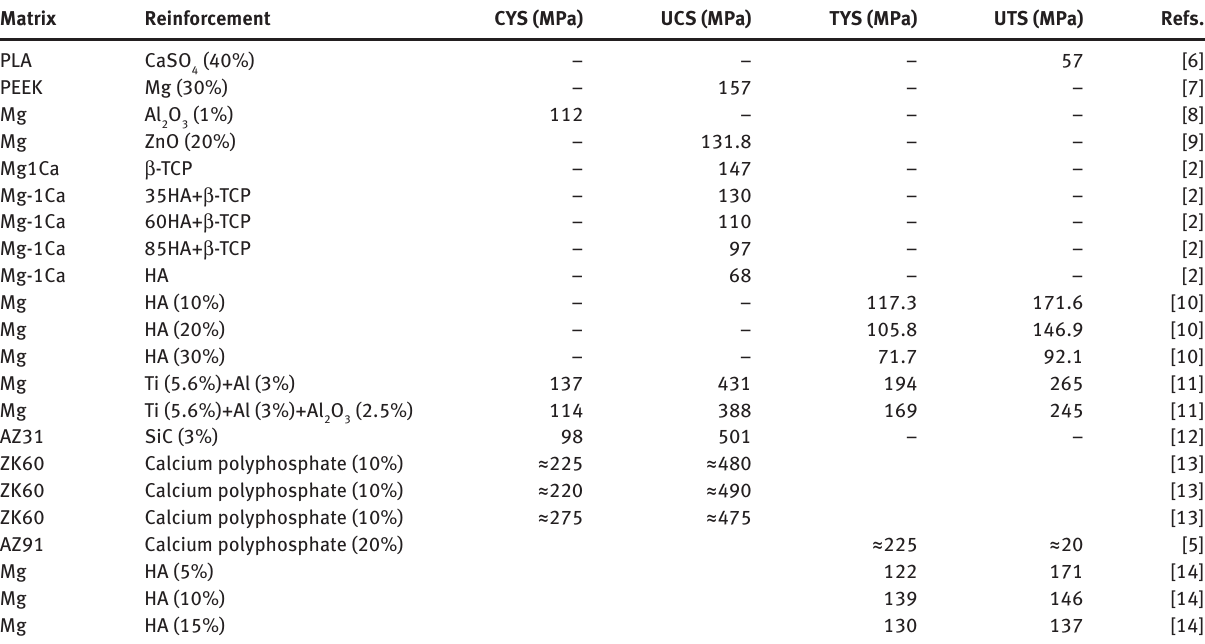
Table 1: Properties of selected materials developed for medical applications. Matrix